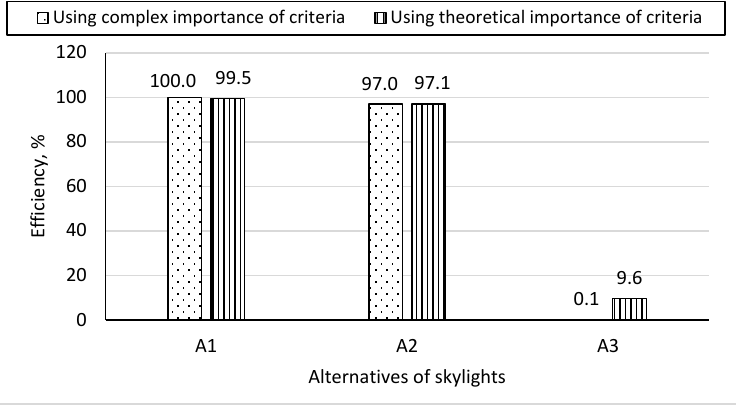
Figure 9. The comparison of performance values of skylights alternatives.